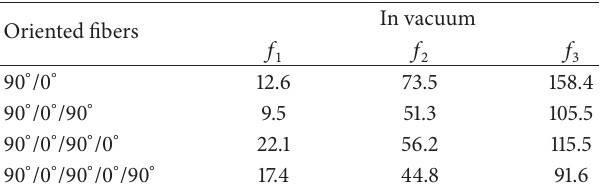
Table 3: Natural frequencies 𝑓 (Hz) of the fin in the case of 90 ∘ /0 ∘ /90 ∘ /0 ∘ /90 ∘ . Oriented fibers